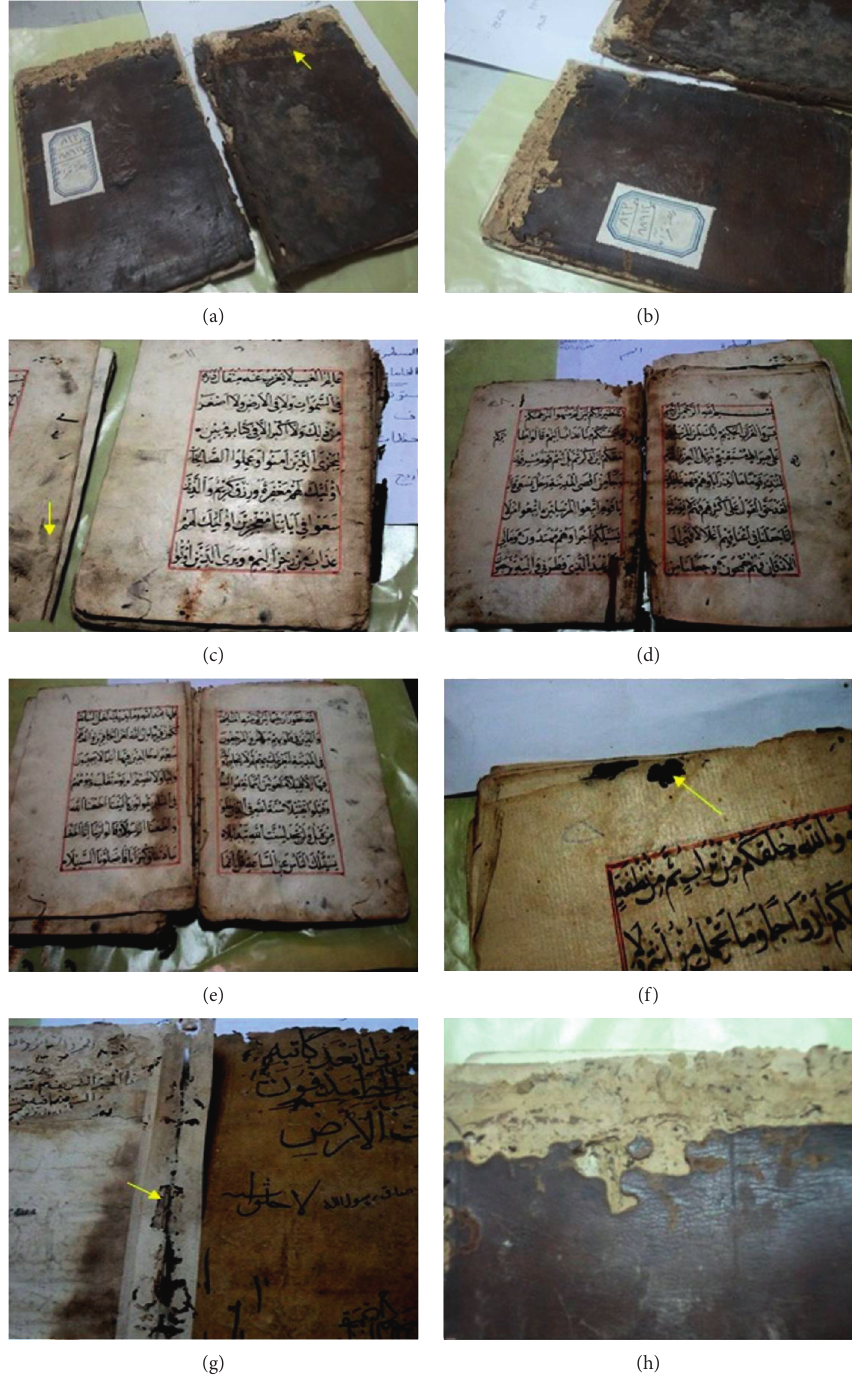
Figure 1: The various damage aspects of the manuscript no. 833. (a) Erosion in the outer cover and loss in different parts of the leather with different mud smears on leather surface. (b) Corrosion in the leather. (c) Patches of soot scattered in the pages of the manuscript. (d) The obvious acidity on the heel of the manuscript and the color and yellowness in the internal papers. (e) The scars in the inner paper. (f) Dark black spots on the edges of the manuscript paper appearing in more than one place in the manuscript. (g) Erosion in paper from the heel area of the manuscript, as indicated by the arrow in addition to the large erosion in the contact areas of the LT. (h) The deep erosion in the leather and paper lining and